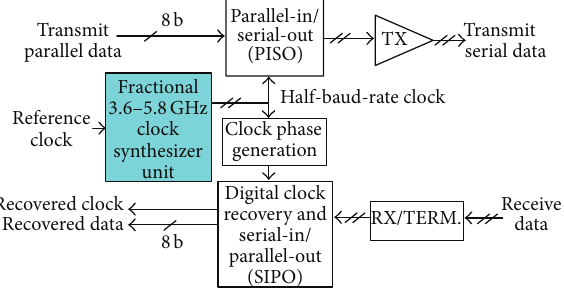
Figure 2: Block diagram of one transceiver link.